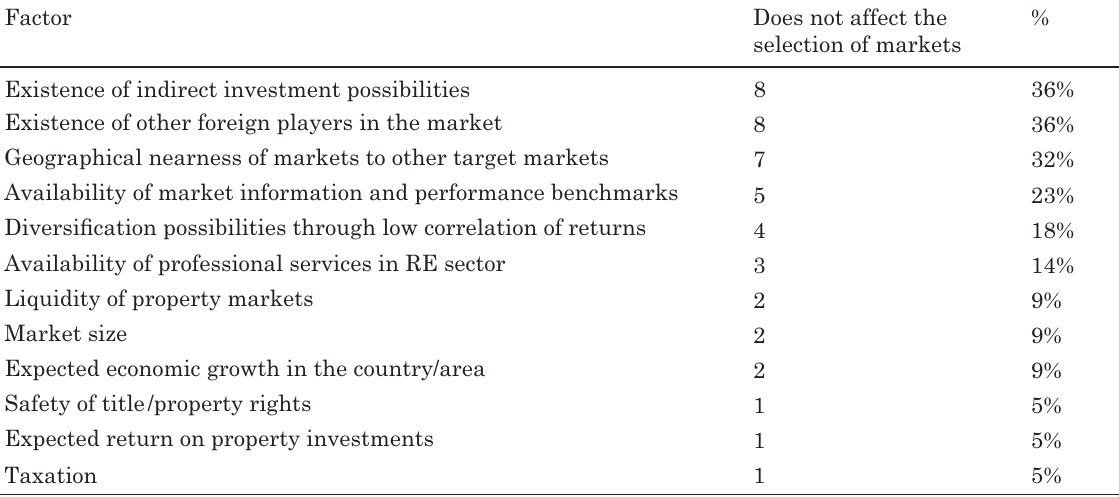
Table 8. Factors that do not affect market selection